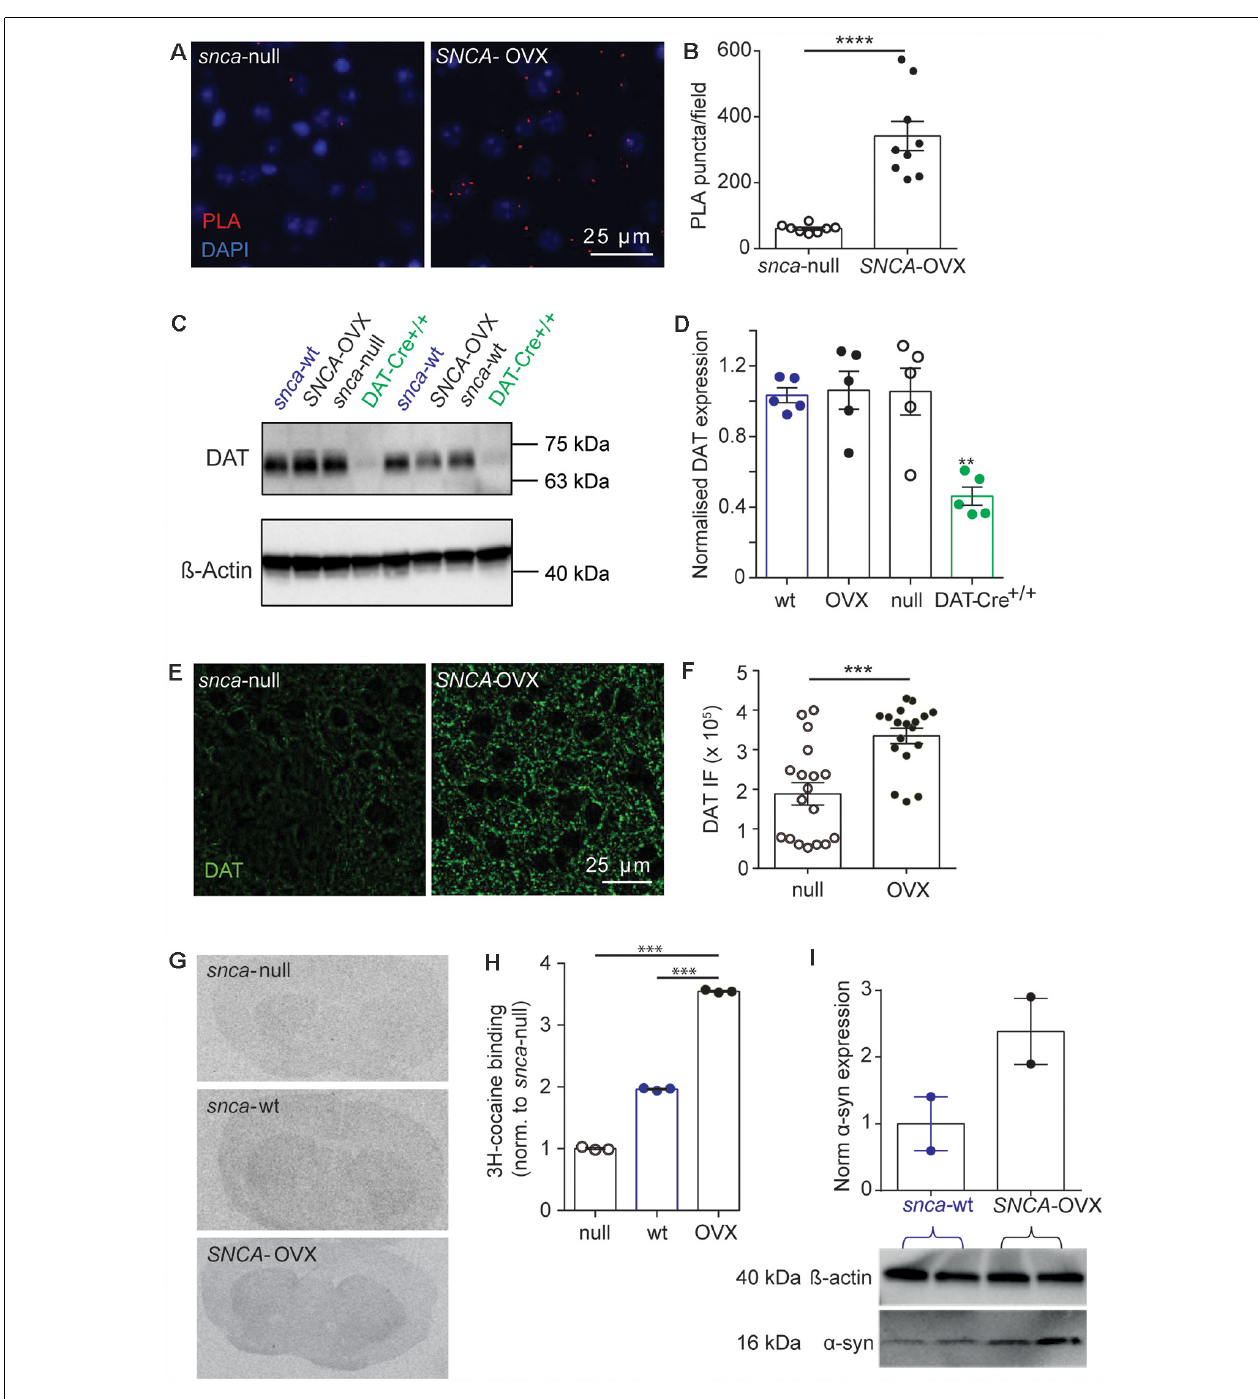
FIGURE 2 | DAT availability is promoted by α -synuclein. (A) Representative images of PLA puncta (DAT: syn-PLA, red ) and DAPI ( blue) in dorsal striatum of Snca -null and SNCA -OVX mice. Scale bar, 25 µ m. (B) Quantification of density of DAT: α -synuclein PLA puncta. Unpaired t -test with Welch’s correction for unequal variances, t (8.156) = 6.285, n = 9 samples, N = 3 animals, **** P < 0.0001. (C) Example Western blots from striatal homogenates showing glycosylated DAT band ( 70 kDa), and actin band ( 42 kDa). (D) DAT levels (relative to actin) in Snca -wt, Snca -null, SNCA -OVX and DAT-Cre +/+ mice. One-way ANOVA: F (3,16) = 1.03, P = 0.001. Post hoc Dunnett’s multiple comparisons test, C57BL/6J vs. DAT-Cre+/+, ** P < 0.01. (E) Representative images of DAT immunofluorescence (IF) in dorsal striatum. Scale bar, 25 µ m. (F) Quantification of DAT IF. Unpaired t -test, t (34) = 4.29, ∗∗∗ P = 0.0001, n = 18, N = 3. (G) Representative autoradiograms demonstrating the distribution of 3 H-cocaine binding sites. (H) Mean ± SEM 3 H-cocaine binding sites in striatum. One-way ANOVA: F (3,7) = 2.47, post hoc Dunnett’s comparisons tests for genotype, N = 3 per genotype, ∗∗∗ P < 0.001. (I) Western blot from striatal homogenates showing pan-species α -synuclein band (16 kDa) and actin band (42 kDa) with normalized quantification of α -synuclein expression, from Snca -wt and SNCA -OVX. N = 2 animals.